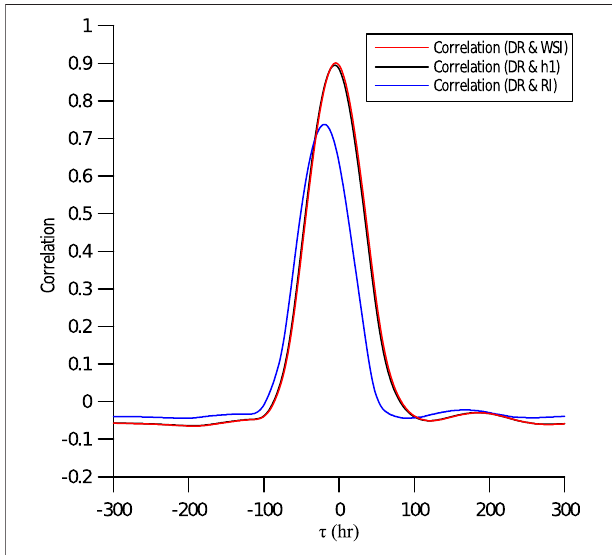
FIGURE 15 | Correlation functions. One-month time series data from 7/ 28/2009 are used for calculation. The negative time shift (negative τ ) representsthetimeleadtotheDR. Thelargehorizontaltimelagaxis ischosen for clearer visual inspection of the correlation